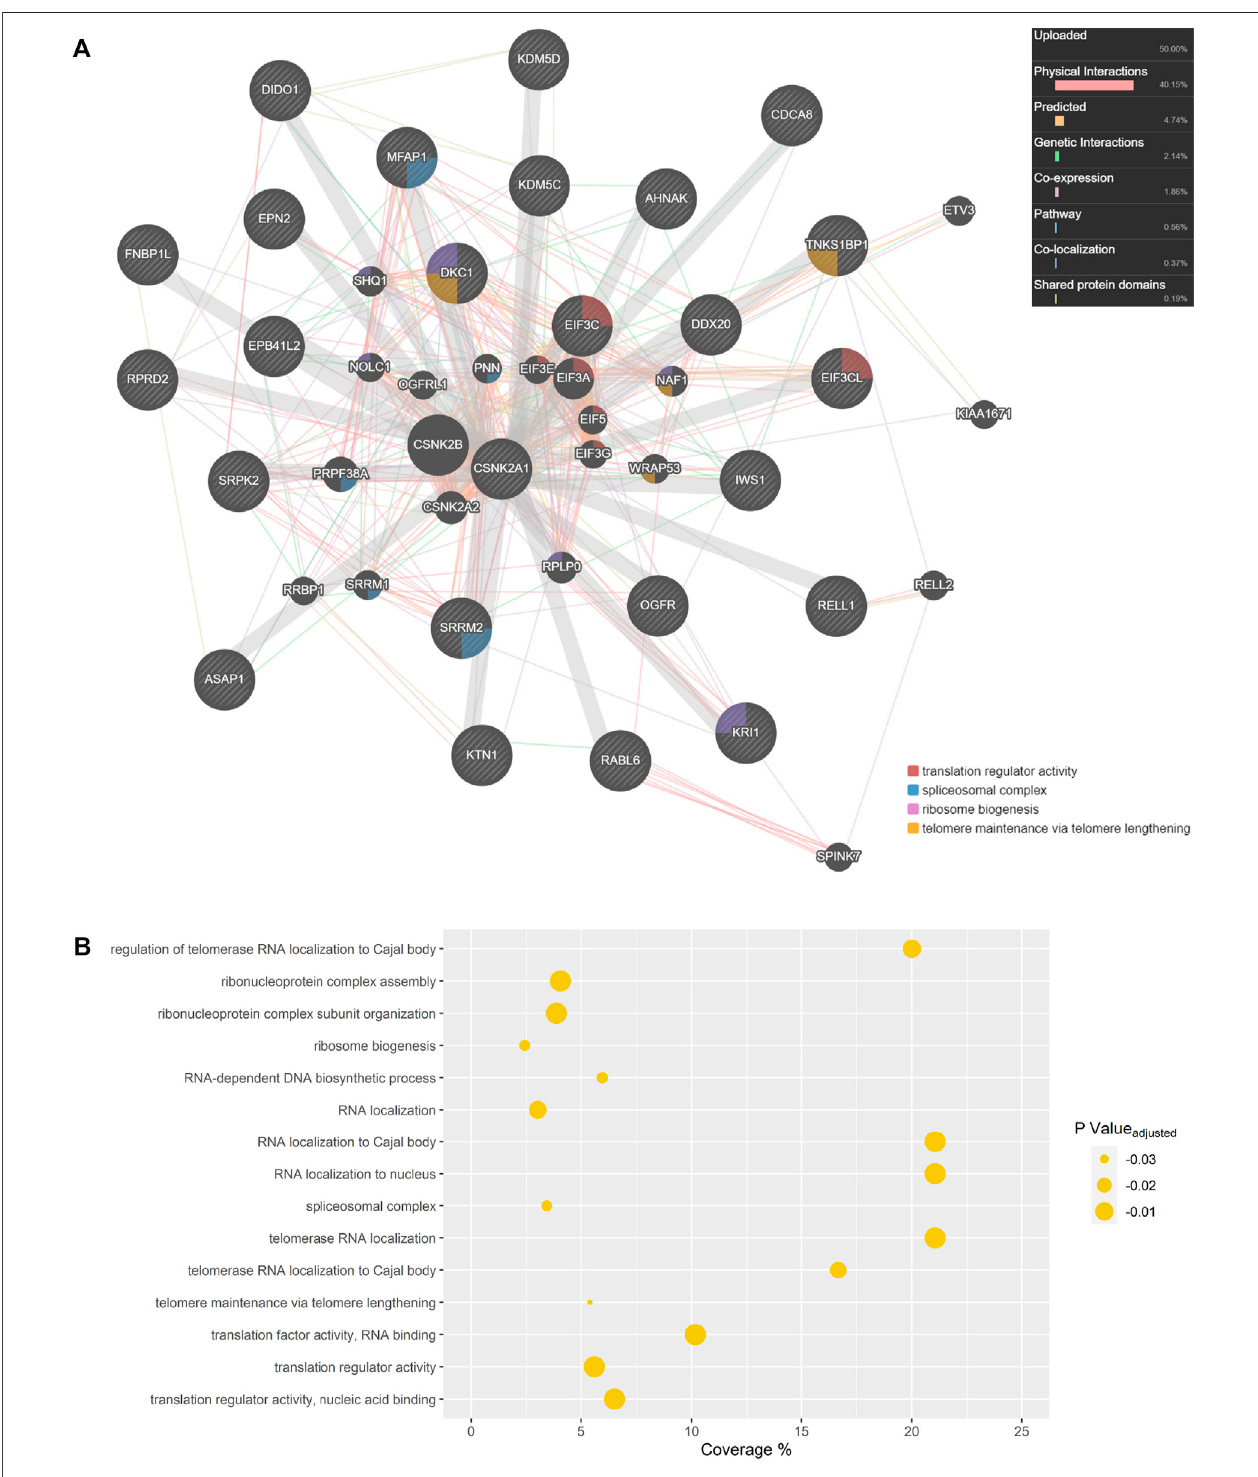
FIGURE 6 | CSNK2A1 Interaction Network. (A) Rescued CSNK2 protein substrates and related proteins are depicted in a GeneMANIA network. Previous databaseinformationregardingphysicalinteractions(red),co-expression(purple),predictedinteractions(orange),geneticinteractions(green),co-localization(blue),and shared protein domains (yellow) were employed in network creation in an “ equal by data type ” weighting approach. Our own list of rescued substrates was utilized in network creation and each assigned a value of 1. If a phosphopeptide was not unique and could have originated from several proteins, all potential proteins were